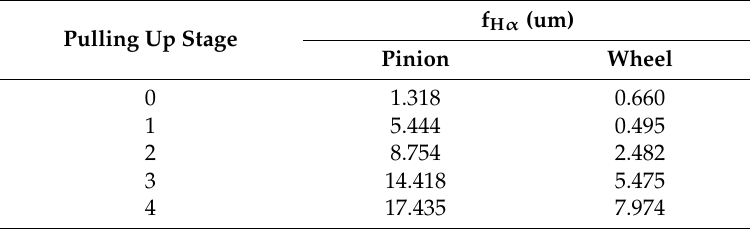
Table 3. Profile slope deviation of test gears before and after pulling